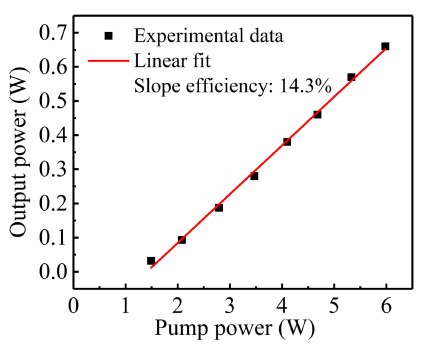
Figure 4. Output power of the main oscillator with increasing incident pump